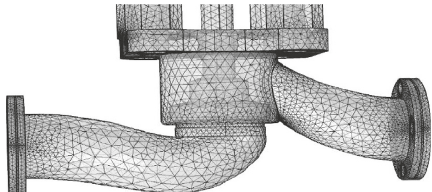
Figure 5: Control valve